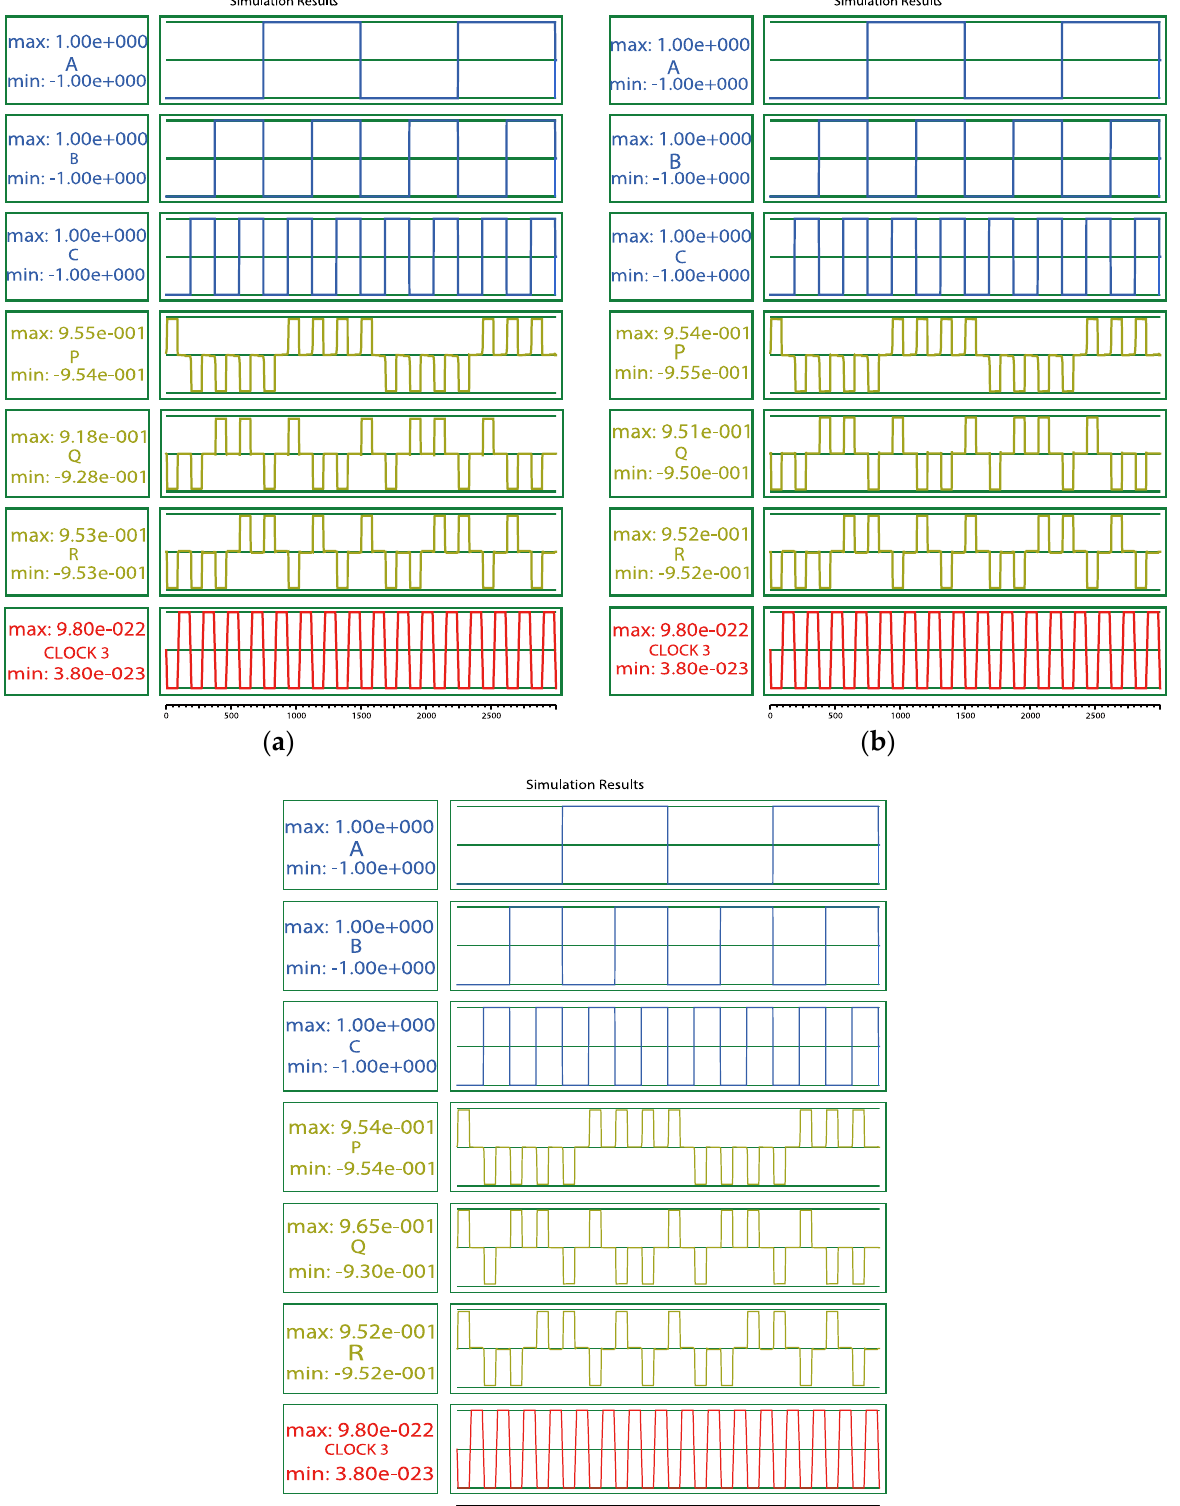
Figure 17. Layouts of the proposed reversible gates. ( a ) the first reversible gate (RG1), ( b ) the second reversible gate (RG2), and ( c ) the third reversible gate implemented by using the XOR in [5] (RG3).